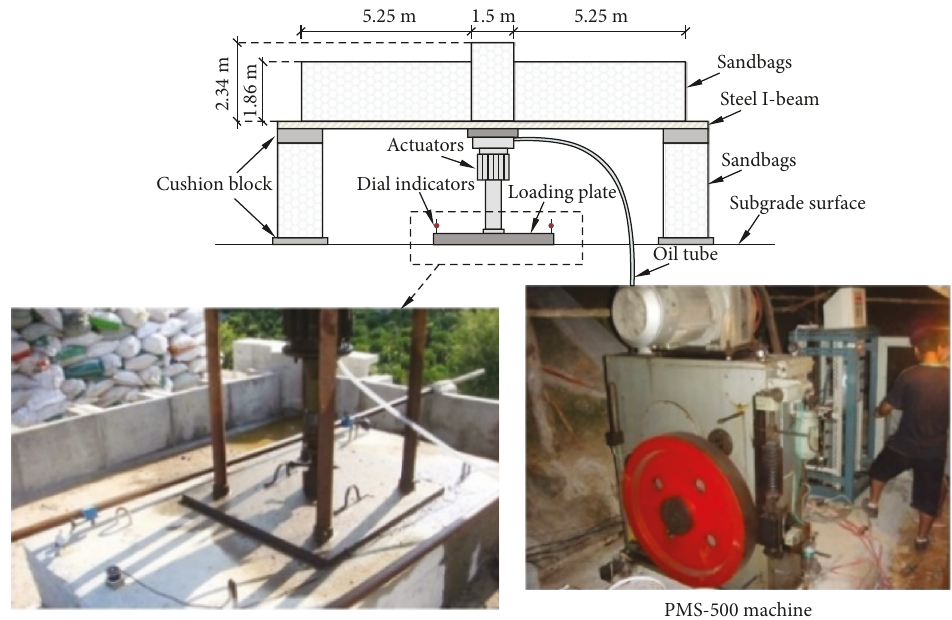
Figure 2: Schematic of loading equipment.